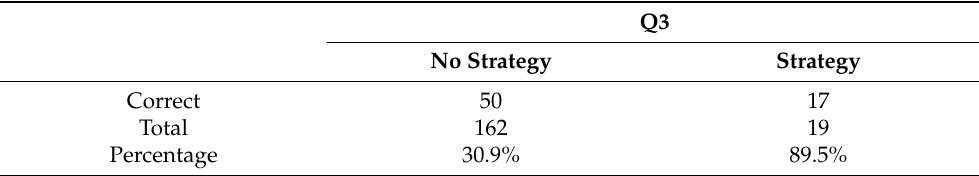
Table 6. Correct responses percentage, according to strategy or not, in Q3.